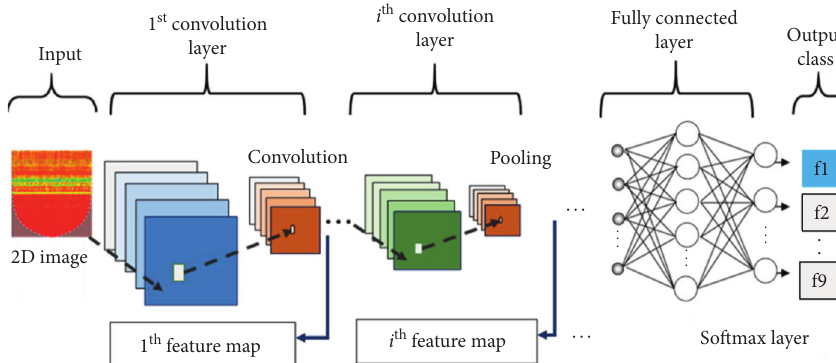
Figure 1: Flowchart of signal processing for fault detection and